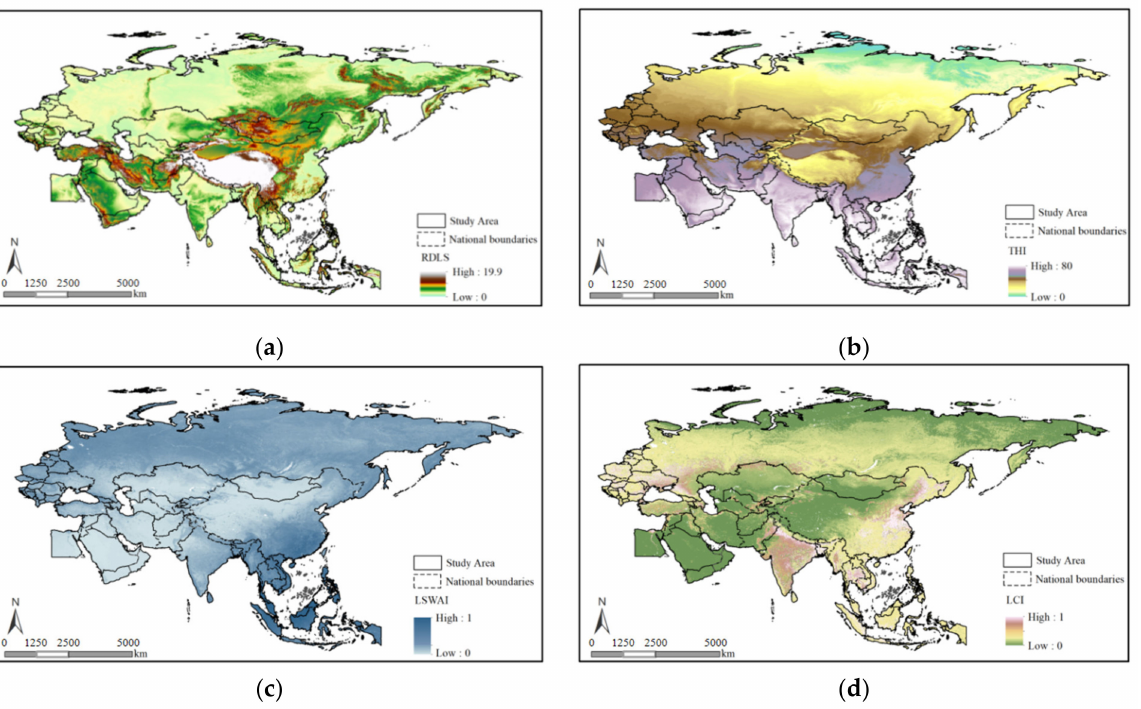
Figure 2. Spatial distribution of the single factors affecting human settlement suitability. Note: ( a ) the RDLS of the BRI, ( b ) the THI of the BRI, ( c ) the LSWAI of the BRI, and ( d ) the LCI of the BRI. As shown in the results calculated using the THI model, the THI varied relatively significantly between the BRI regions. Except for the Tibetan Plateau, the THI gradually decreased from the low-latitude regions in the south to the high-latitude regions in the north. Extremely cold regions, with the THI below 40, were mainly located in high-latitude and high-altitude zones, including Northern Kazakhstan, Northeastern China, the Tibetan Plateau, the Tianshan Mountains, and the Pamir Mountains in Central Asia. Regions with a THI between 45 and 75, at which the human body feels relatively comfortable, were primarily distributed in most of the zones between 20 ◦ N and 45 ◦ N, except for the Tibetan Plateau, Pamir Mountains, and the surrounding high-altitude zones. Regions with a THI higher than 75 had a hot and humid climate, which were primarily distributed along the southeastern coast of Bangladesh and India, the Southern Indochinese Peninsula, and in most of the Malay